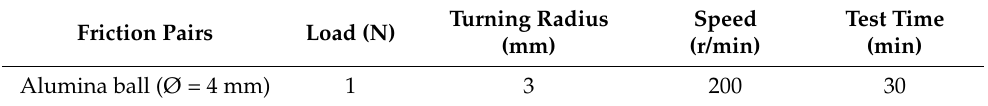
Table 1. Process parameters for the wear